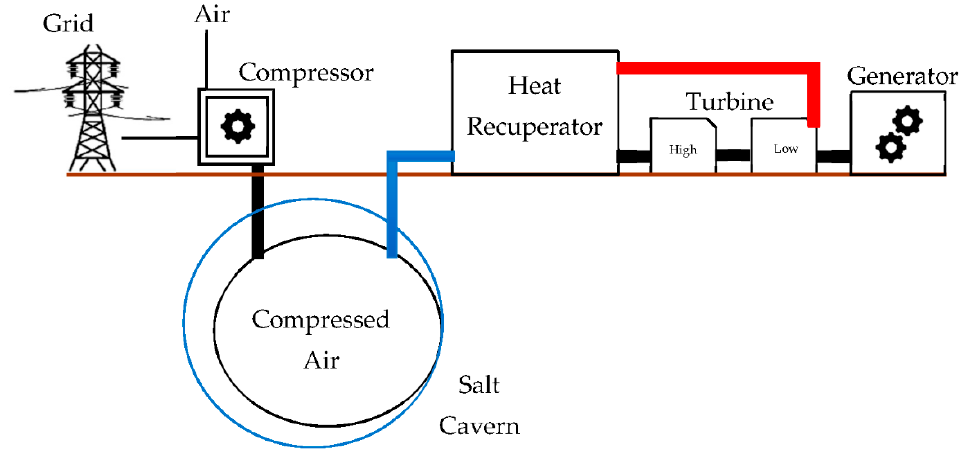
Figure 3. Scheme of Diabatic CAES system. Adapted from [23].